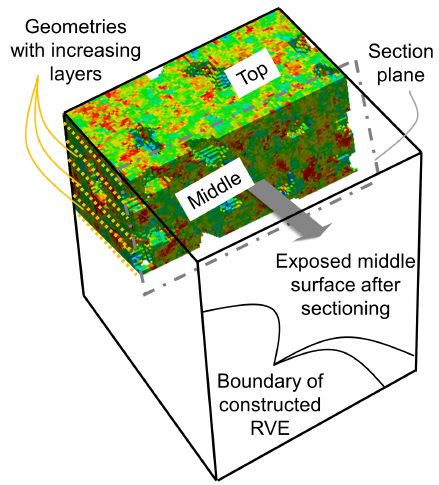
Figure 4. Schematic diagram showing the sectioning scheme to expose the middle and top surfaces for visual comparison of local stress and strain in the upcoming figures. Local von Mises true stress distribution in the ferrite phase has been used here just as an example for color coding of the section of interest.